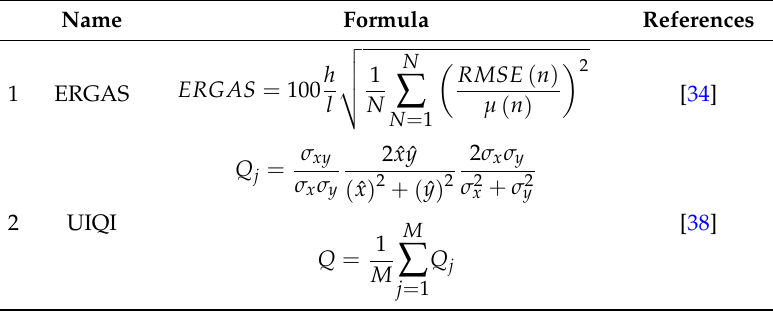
Table 2. The quality assessment metrics used in the study that require a reference image. (ERGAS: relative global dimensionless synthesis error; SAM: spectral angle mapper; UIQI: universal image quality